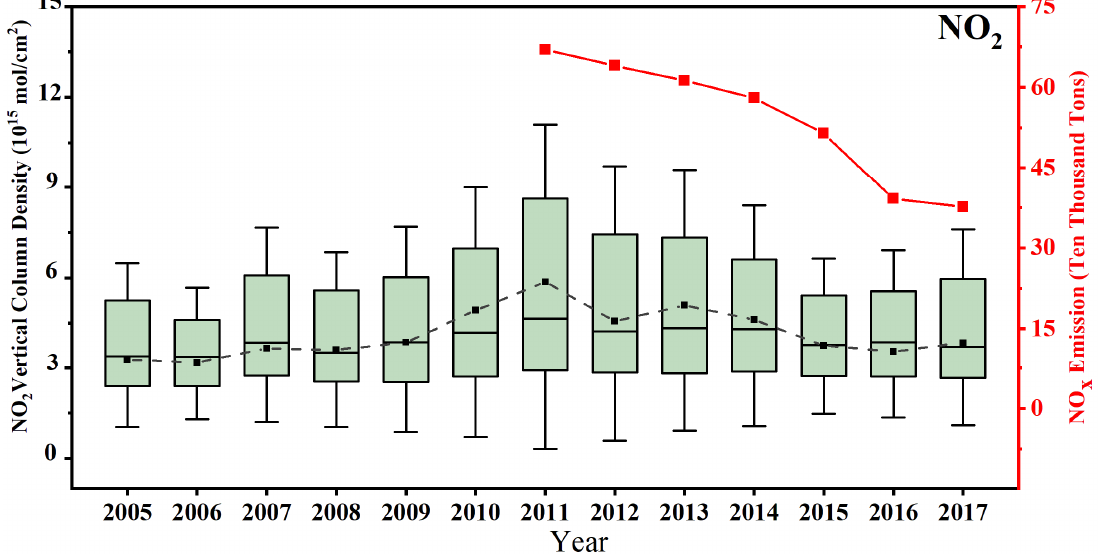
Figure 6. The same as Figure 3 but for NO 2 .